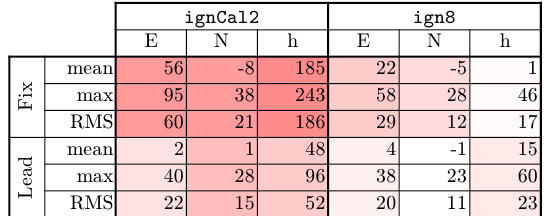
Table 4. Checkpoints statistics (in mm ) when the calibration from ignCal2 and ign8 is used for processing ign6xl . “Fix” means that calibration is used as it is, while “Lead” that f and c x , c y are re-adjusted. Color coding w.r.t. the best obtained